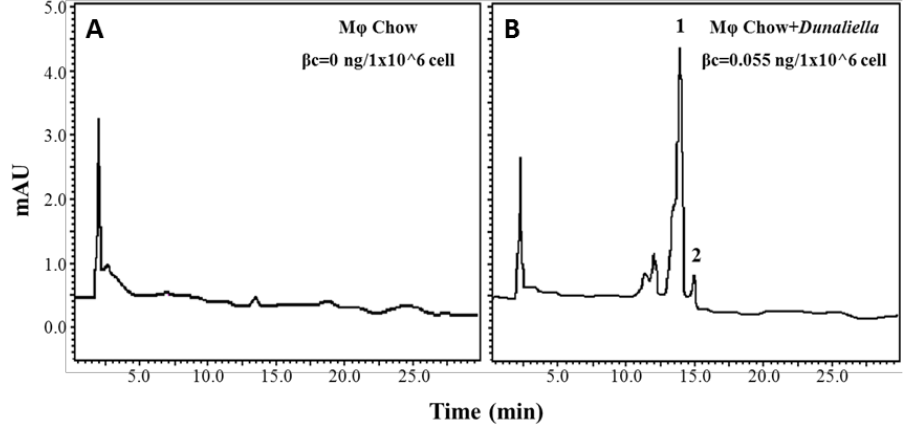
Figure 1. Increased accumulation of carotenoids in peritoneal macrophages isolated from mice fed with a βc rich diet. High-Performance Liquid Chromatography (HPLC) chromatograms of carotenoids in peritoneal macrophages isolated from LDLR–/– mice fed chow diet for four weeks in the absence ( A ) or presence of Dunaliella ( B ). 1-all- trans - βc, 2 -9- cis - βc. Separation was conducted on C30 column and detection at 450 nm. φ, macrophages.